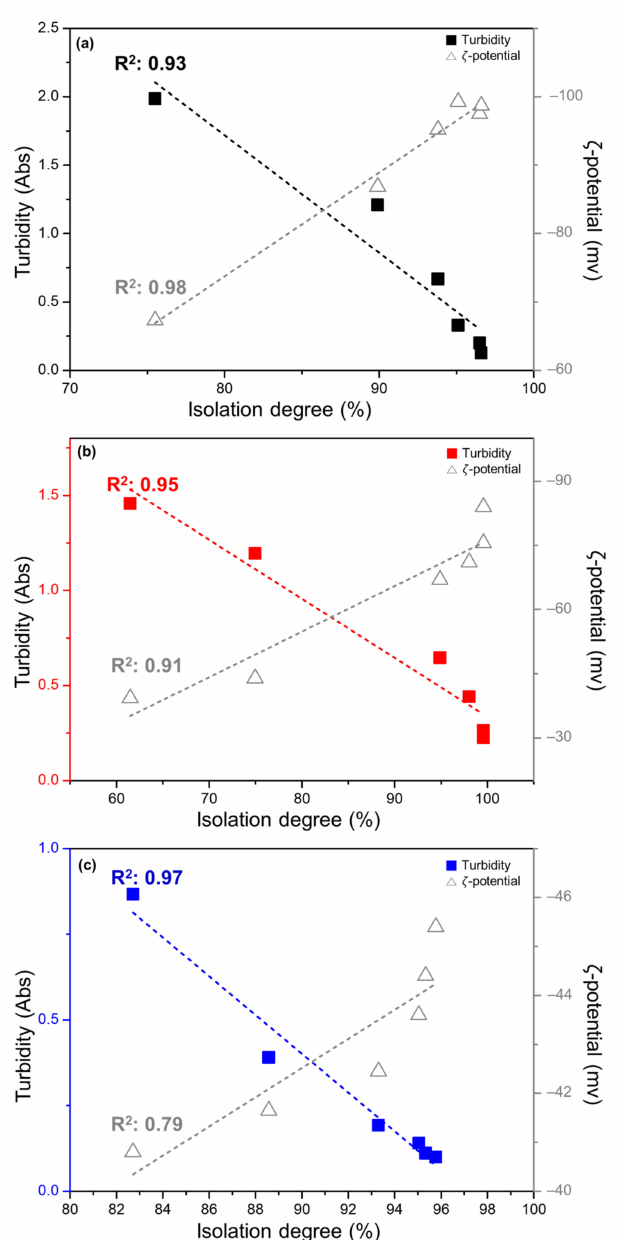
Figure 6. Comparison of turbidity, zeta potential and isolation degree of the various CNCs suspen- sions. ( a ): CNCs (MCC), ( b ): CNCs (SWP), ( c ): CNCs